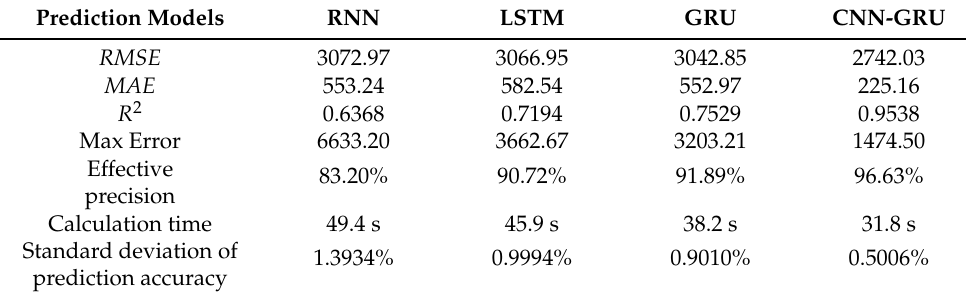
Table 6. Model evaluation metrics after feature